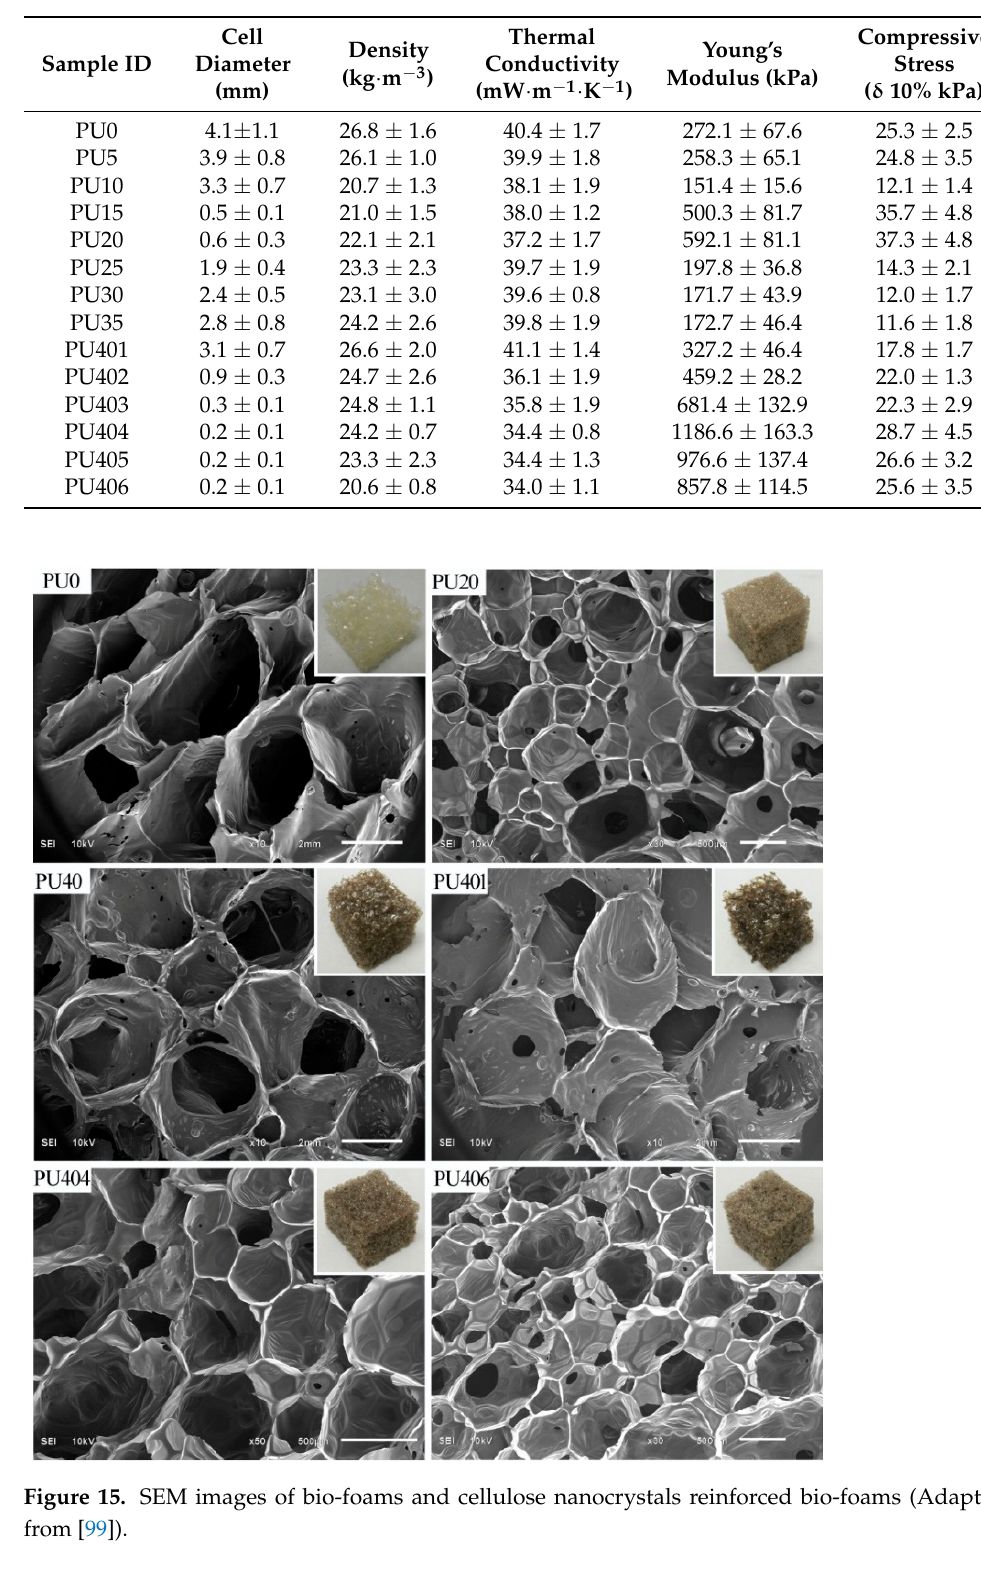
Table 6. Cell diameter, physicomechanical properties of the bio-foams, and cellulose nanocrystals reinforced bio-foams [99].